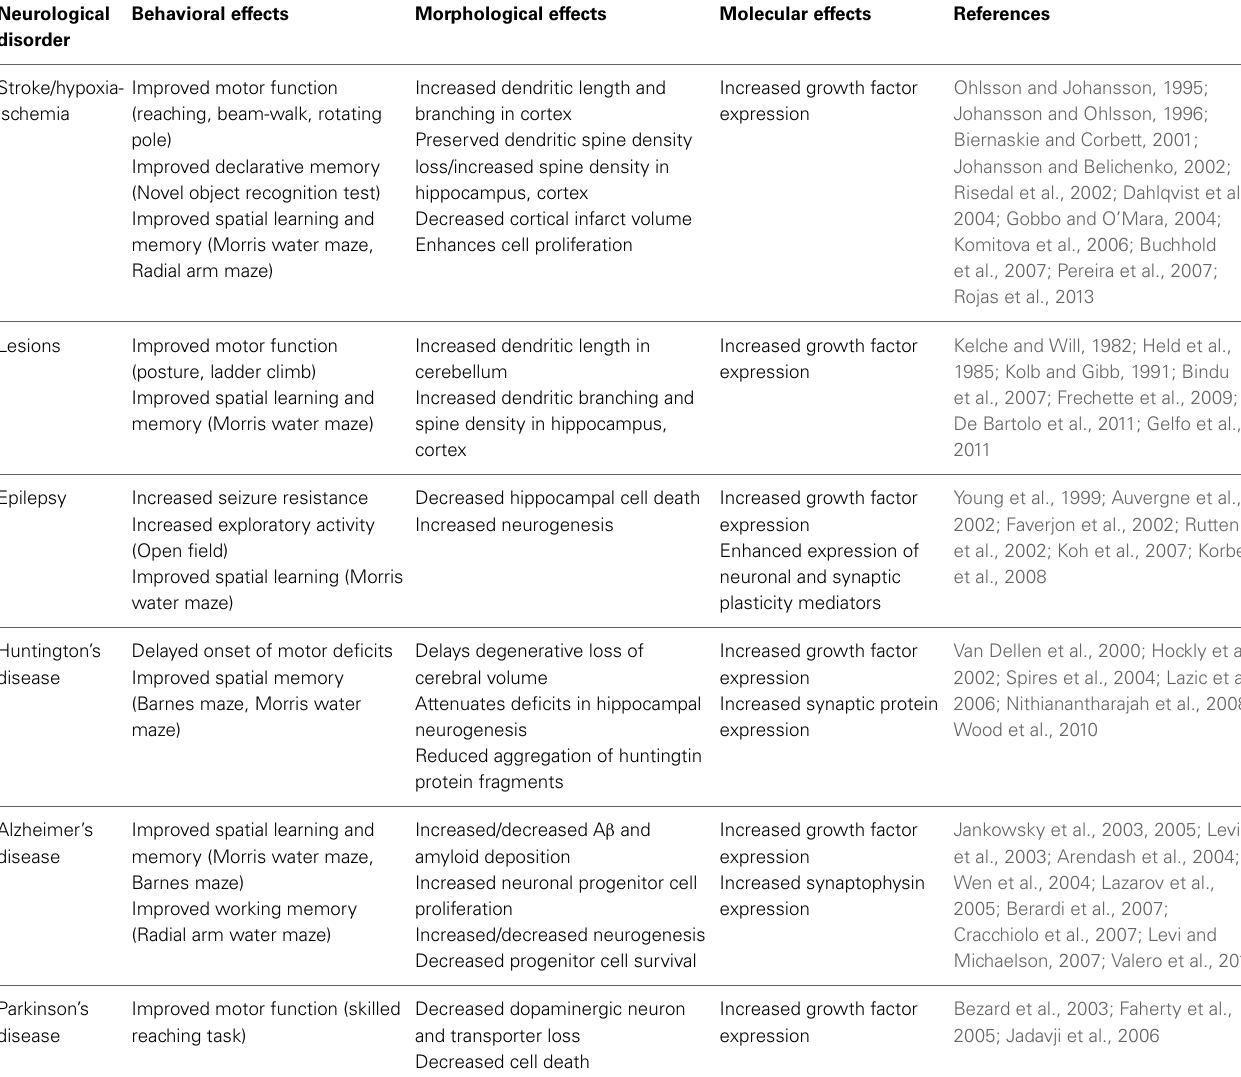
Table 1 | Behavioral, morphological, and molecular effects of EE in various neurological disease